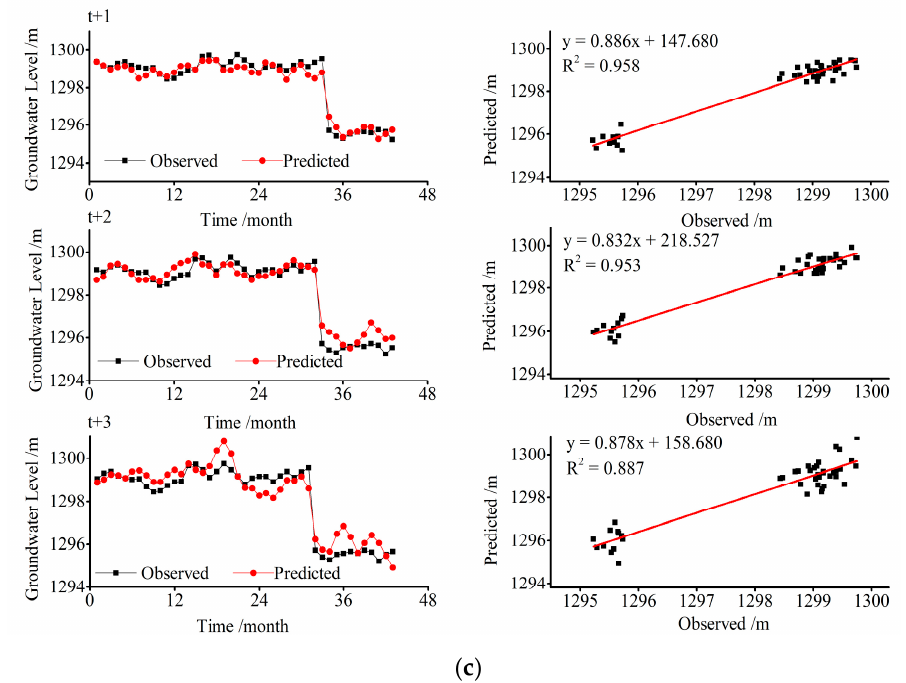
Figure 5. Observed groundwater level and forecasted by VBELM model for 1, 2 and 3-month ahead during the testing period at Well I ( a ), Well II ( b ) and Well III ( c ).